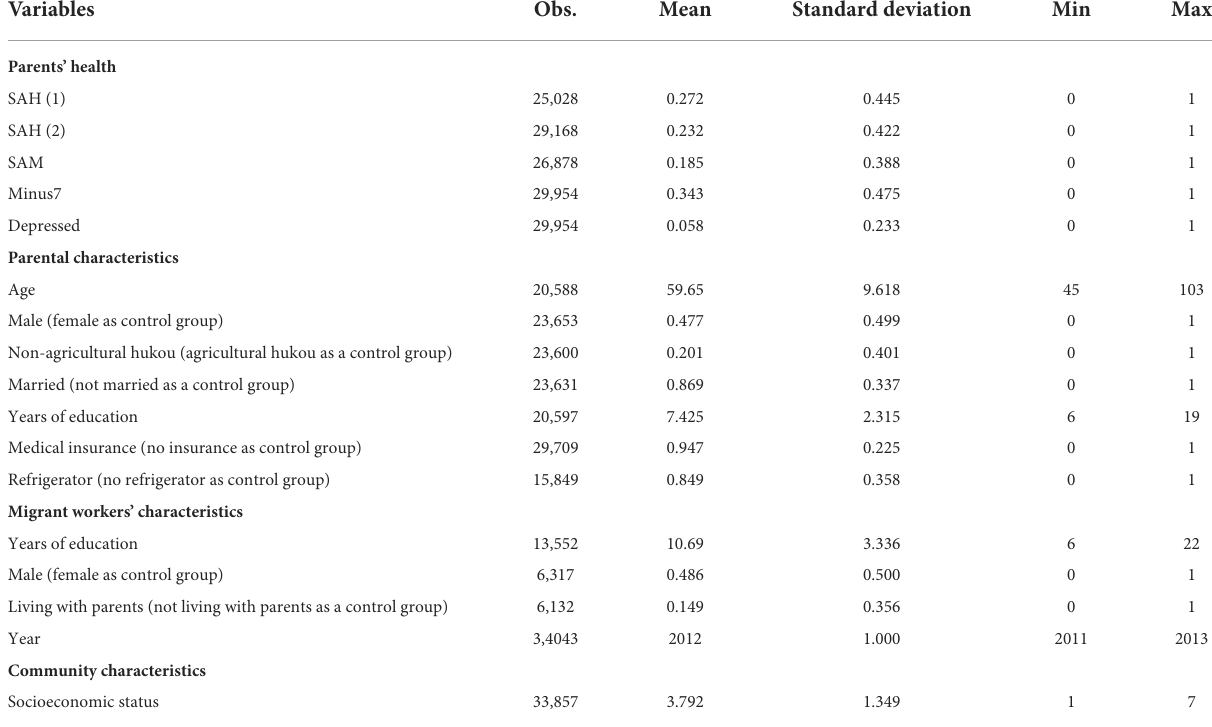
TABLE 1 Basic information of the